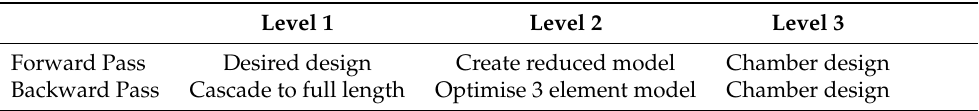
Figure 3. A complete hierarchical framework with figure representations of each hierarchical step in the framework. Table 1. Hierarchical case study